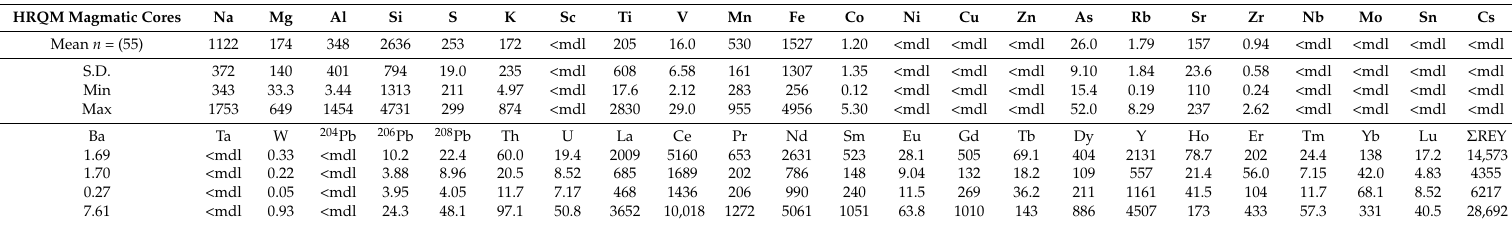
Table 3. REE and trace element concentrations in apatite from the Horn Ridge quartz monzonite (ppm). Apatite analyses were performed on multiple apatite grains in sample 2274-1. <mdl—below minimum detection limit.